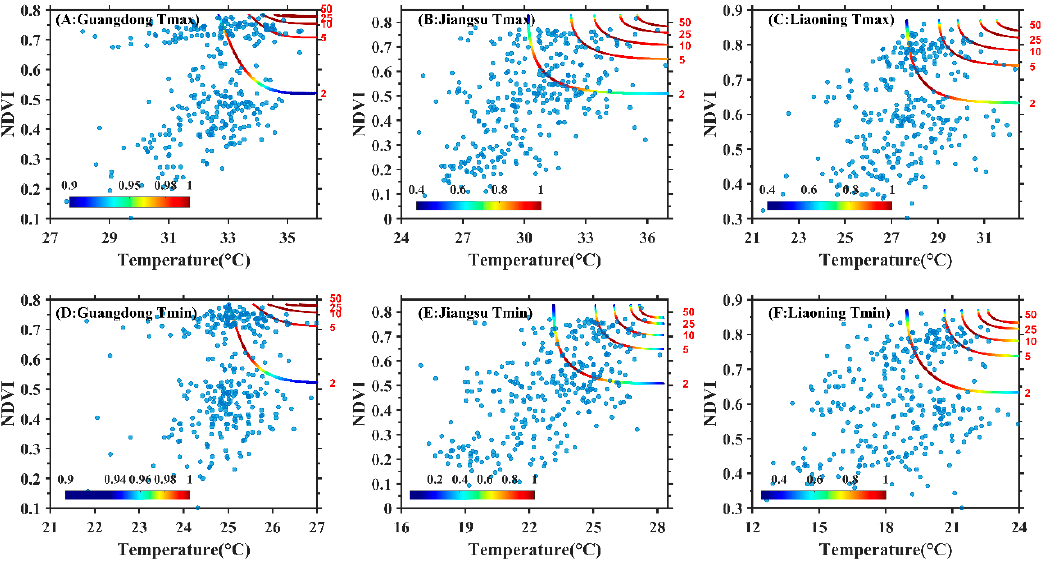
Figure 7. Copula joint return periods of Tmax–NDVI and Tmin–NDVI in summer in Guangdong, Jiangsu and Liaoning from 1982 to 2016.